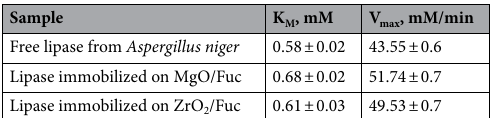
Table 1. Kinetic parameters (K M and V max ) of free and immobilized lipase from Aspergillus niger.